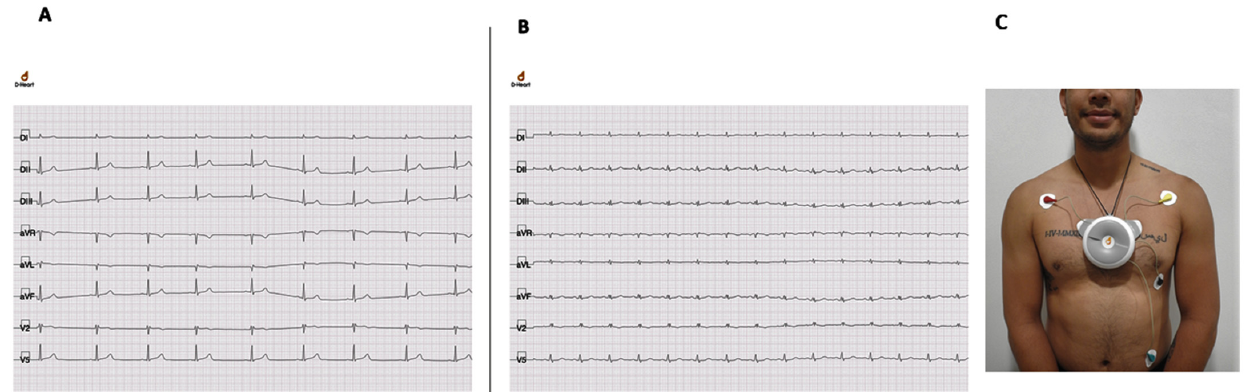
Figure 1. ECG samples of patients referred to further second level examinations and Smartphone ECG device used in the screening activities. ( A ) 45-year old man, active smoker with history of chest pain; his ECG showed sinus bradycardia with a RBBB; ( B ) 59-year old woman, with history of palpitations, leg oedema, chest pain and loss of consciousness; at ECG, a RBBB and low voltages were present. ( C ) Patient during screening activities with D-Heart Smartphone ECG device operating. The D-Heart device can record either 8- or 12-lead ECGs. In the 8-lead setting, DI, DII, and DIII leads are directly measured, as well as precordial unipolar leads V2 and V5. Augmented leads aVR, aVL, and aVF are calculated by definition. In the 12-lead settings, the unipolar electrode in V5 is sequentially placed in V6, V4, V3, V1 position to acquire all the precordial recordings.